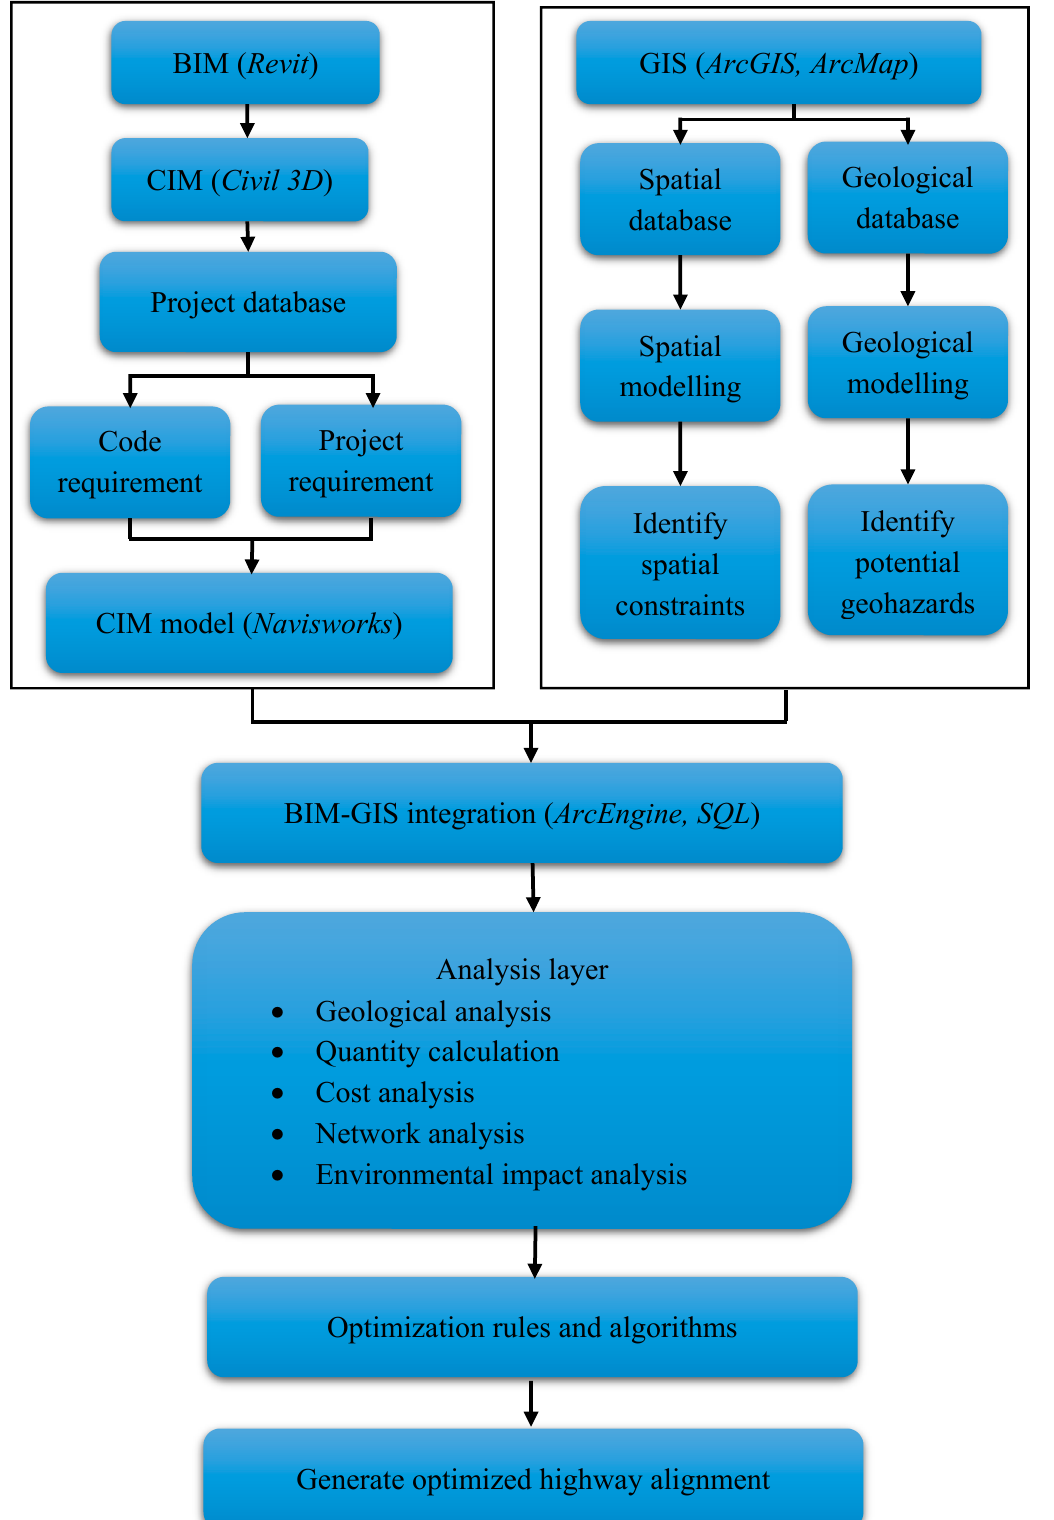
Figure 1. Overview of the proposed